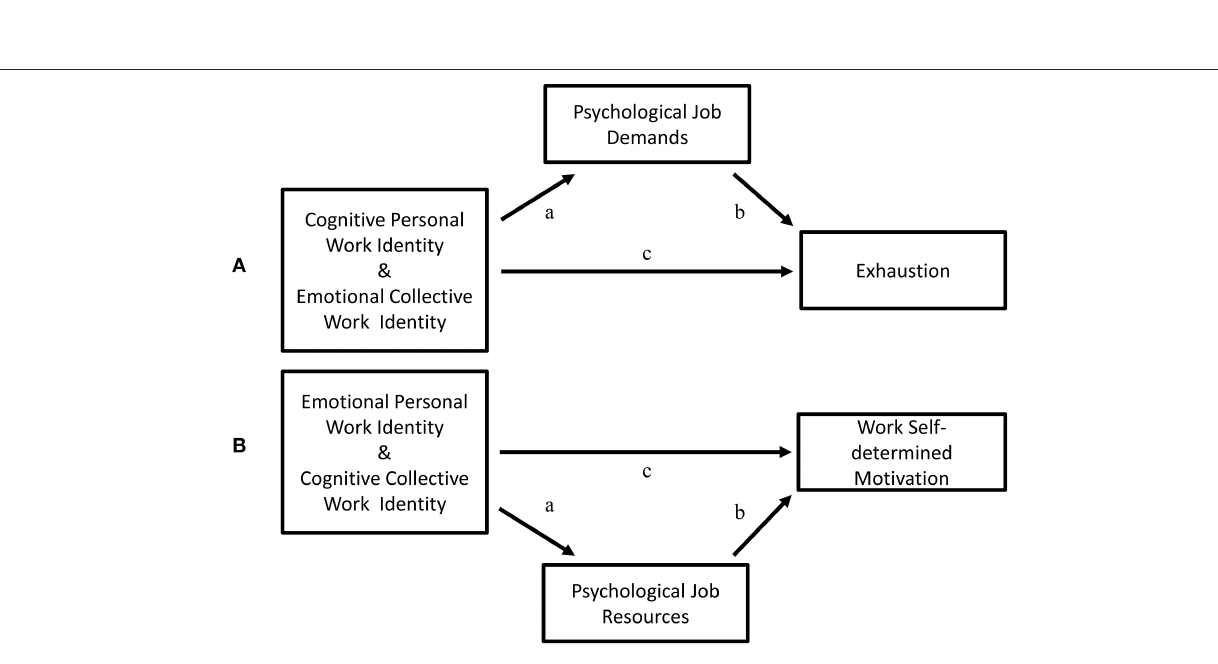
FIGURE 2 | (A) Cognitive personal work-identity and emotional collective work identity as predictors of exhaustion = path c, mediated by psychological job demands = path ab. (B) Emotional personal work-identity and cognitive collective work identity as predictors of work self-determined motivation = path c, mediated by psychological job resources = path